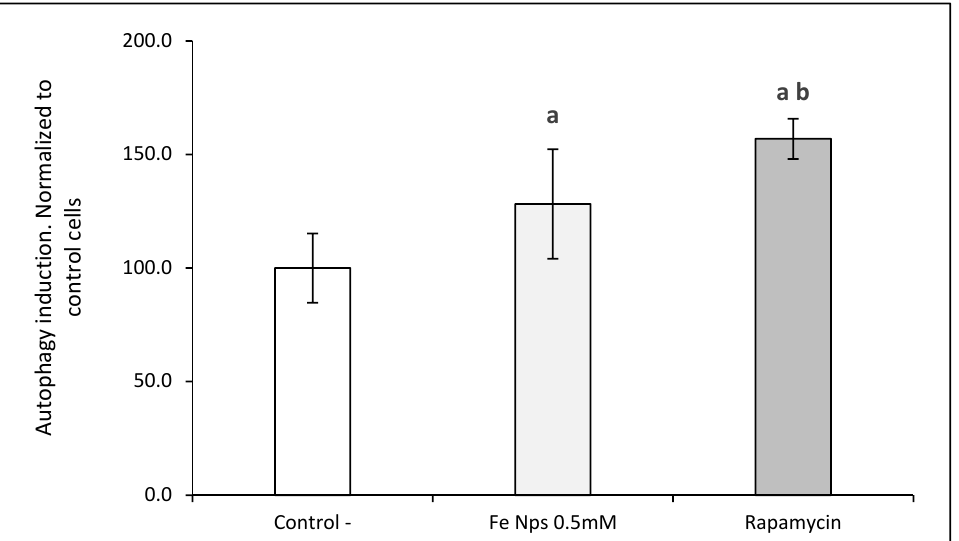
Figure 7. Autophagy induction evaluated by fluorescence using a microplate reader in HT-29 normalized to control cells (untreated). 5 mmol L − 1 , rapamycin 0.5 µmol L − 1 and control cells (untreated). Results expressed as mean ± SEM. (a) vs. control; (b) vs. Fe NPs 0.5 mmol L − 1 ( p < 0.05).